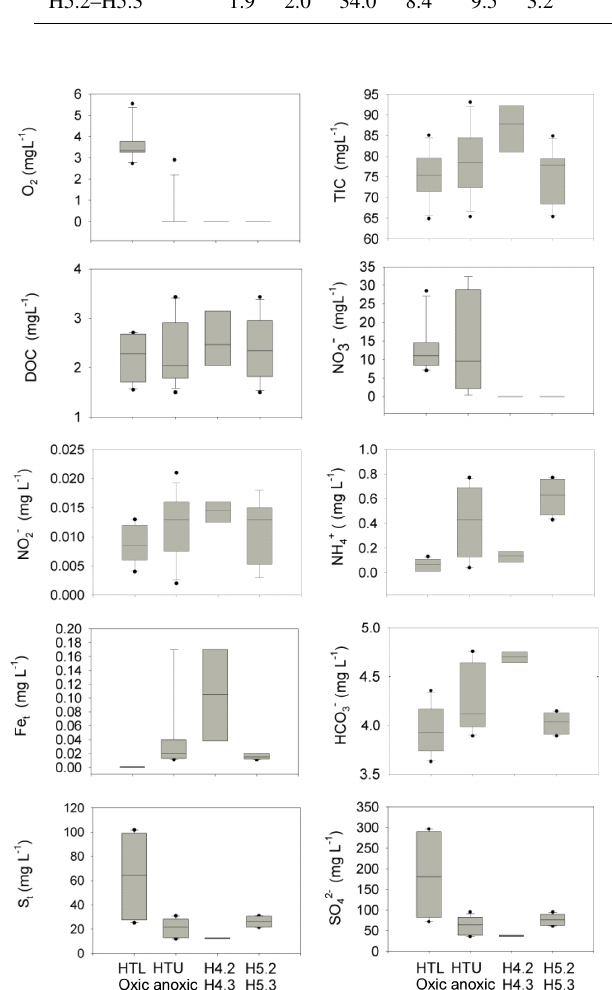
Figure 2. Variations of the chemical compositions of the ground- waters relevant for the discussion. HTL and HTU refer to the wells of the lower and upper aquifer assemblage, respectively. Chemical